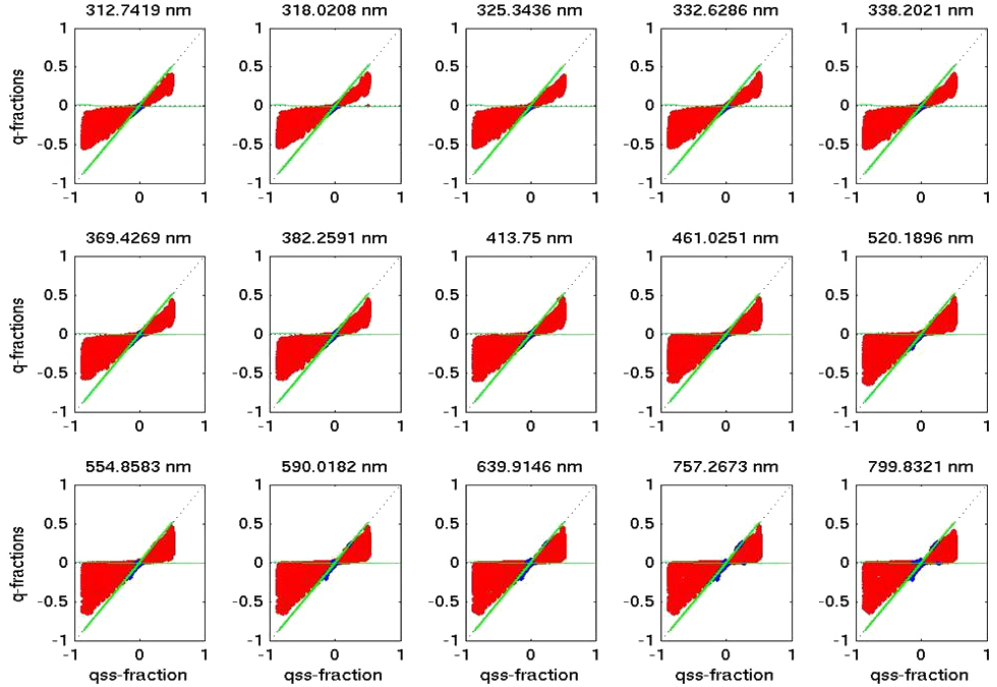
Figure 13. Limiting atmosphere plot for Earth radiance q Stokes fractions and for all PMD bands. The data are derived from one orbit on 31 July 2009. The green lines indicate the Rayleigh single scattering values and q = 0. Red points lie inside the physically reasonable range, while blue points lie outside the physically reasonable